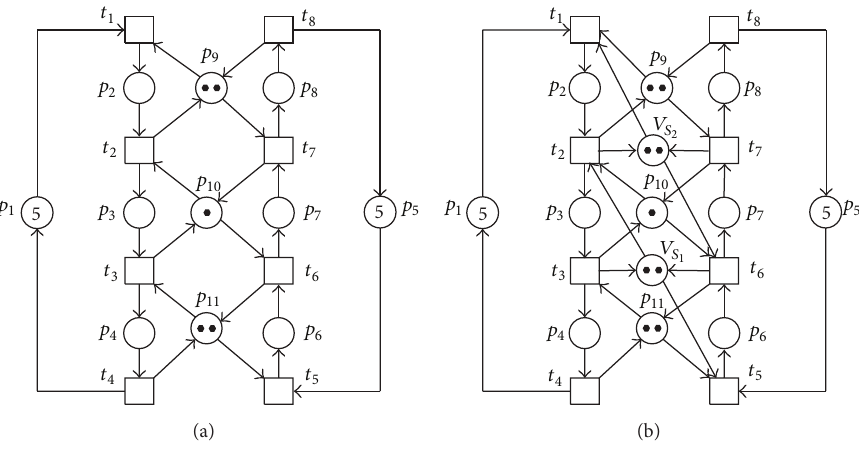
Figure 2: (a) An S 3 PR (𝑁,𝑀 0 ) and (b) a controlled system of 𝑁